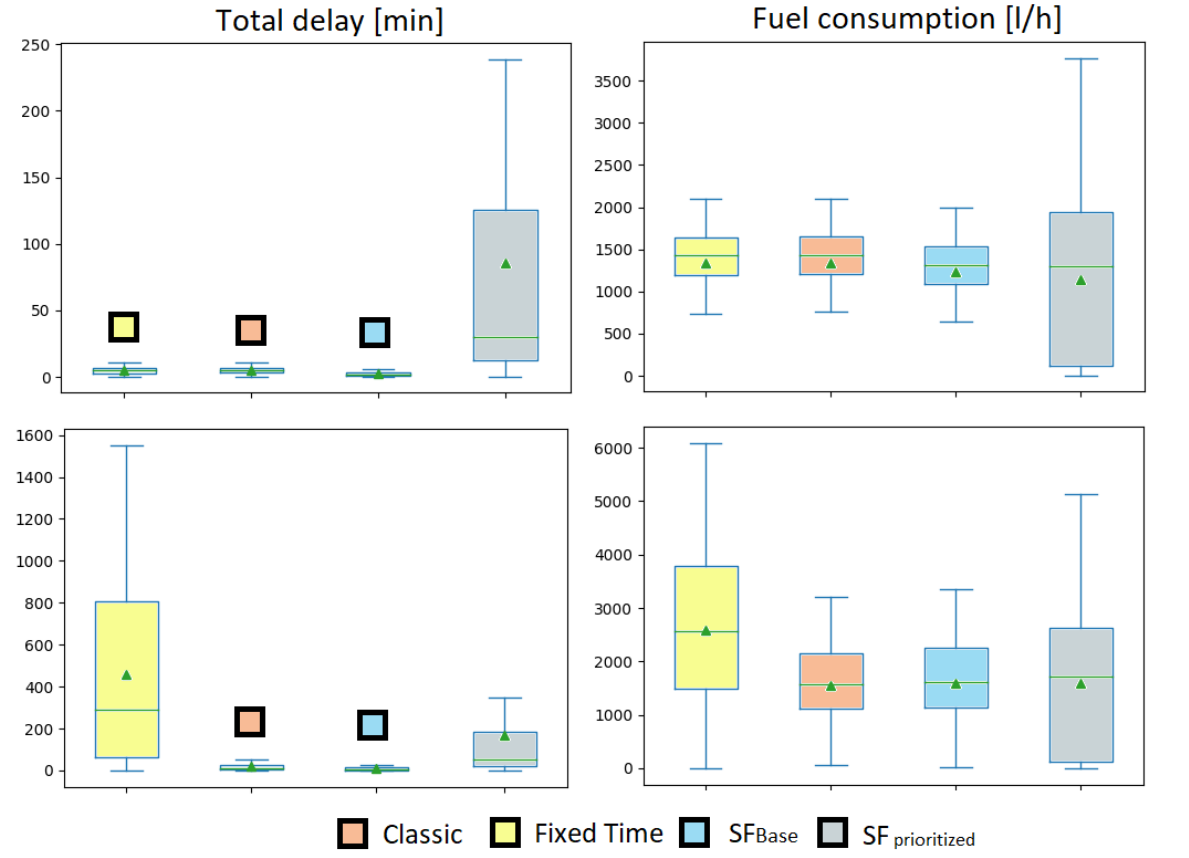
Figure 3. Comparison of different methods with our solution when the prioritized vehicle passing has high importance ( w prio = [ 0,0,0,0,1 ] ). Top row: metrics for 1000 episodes with uniform traffic. Bottom row: metrics for 1000 episodes with asymmetric